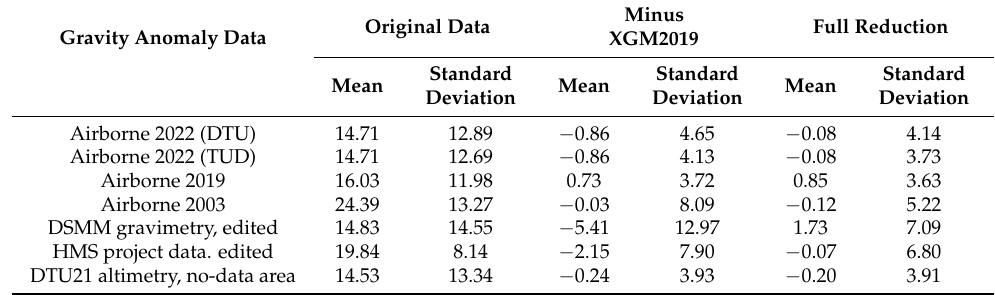
Figure 11. XGM2019/RTM reduced airborne (2003–2022) and DTU21 data outside the airborne coverage. Table 9. Statistics for the gravity data and reductions from the XGM2019 and RTM (mGal).